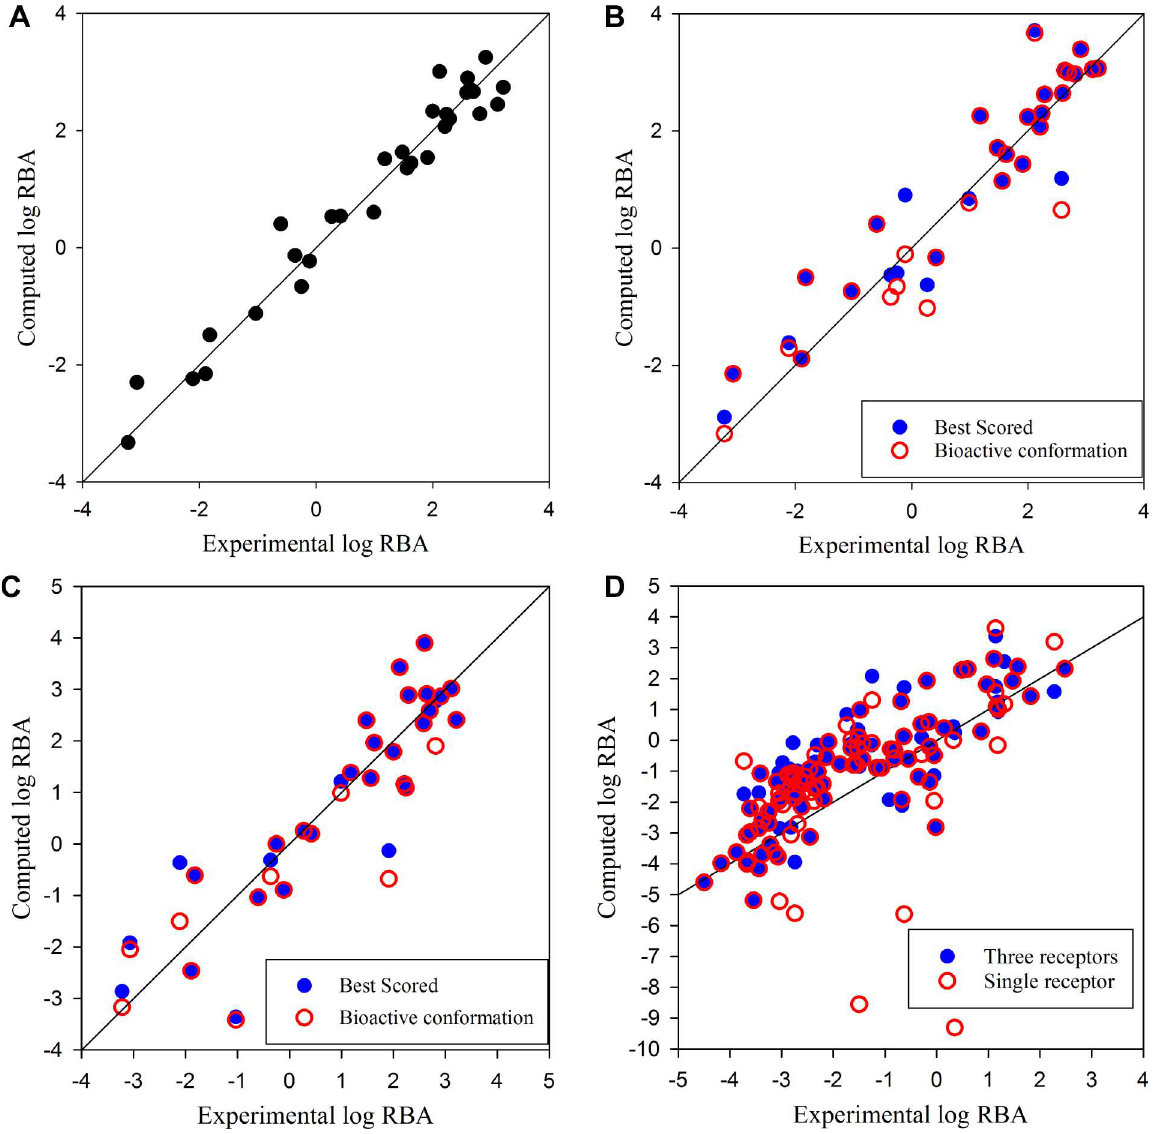
Fig 2. Scatter plots of log RBA calculatedfor 31 trainingligands(A, B, and C) and 111 externaltest ligands(D). Protein-ligand complex structures were obtainedfrom crystal structures (A), self-docking(B), cross-docking (C), and singleor three receptor structures-baseddocking